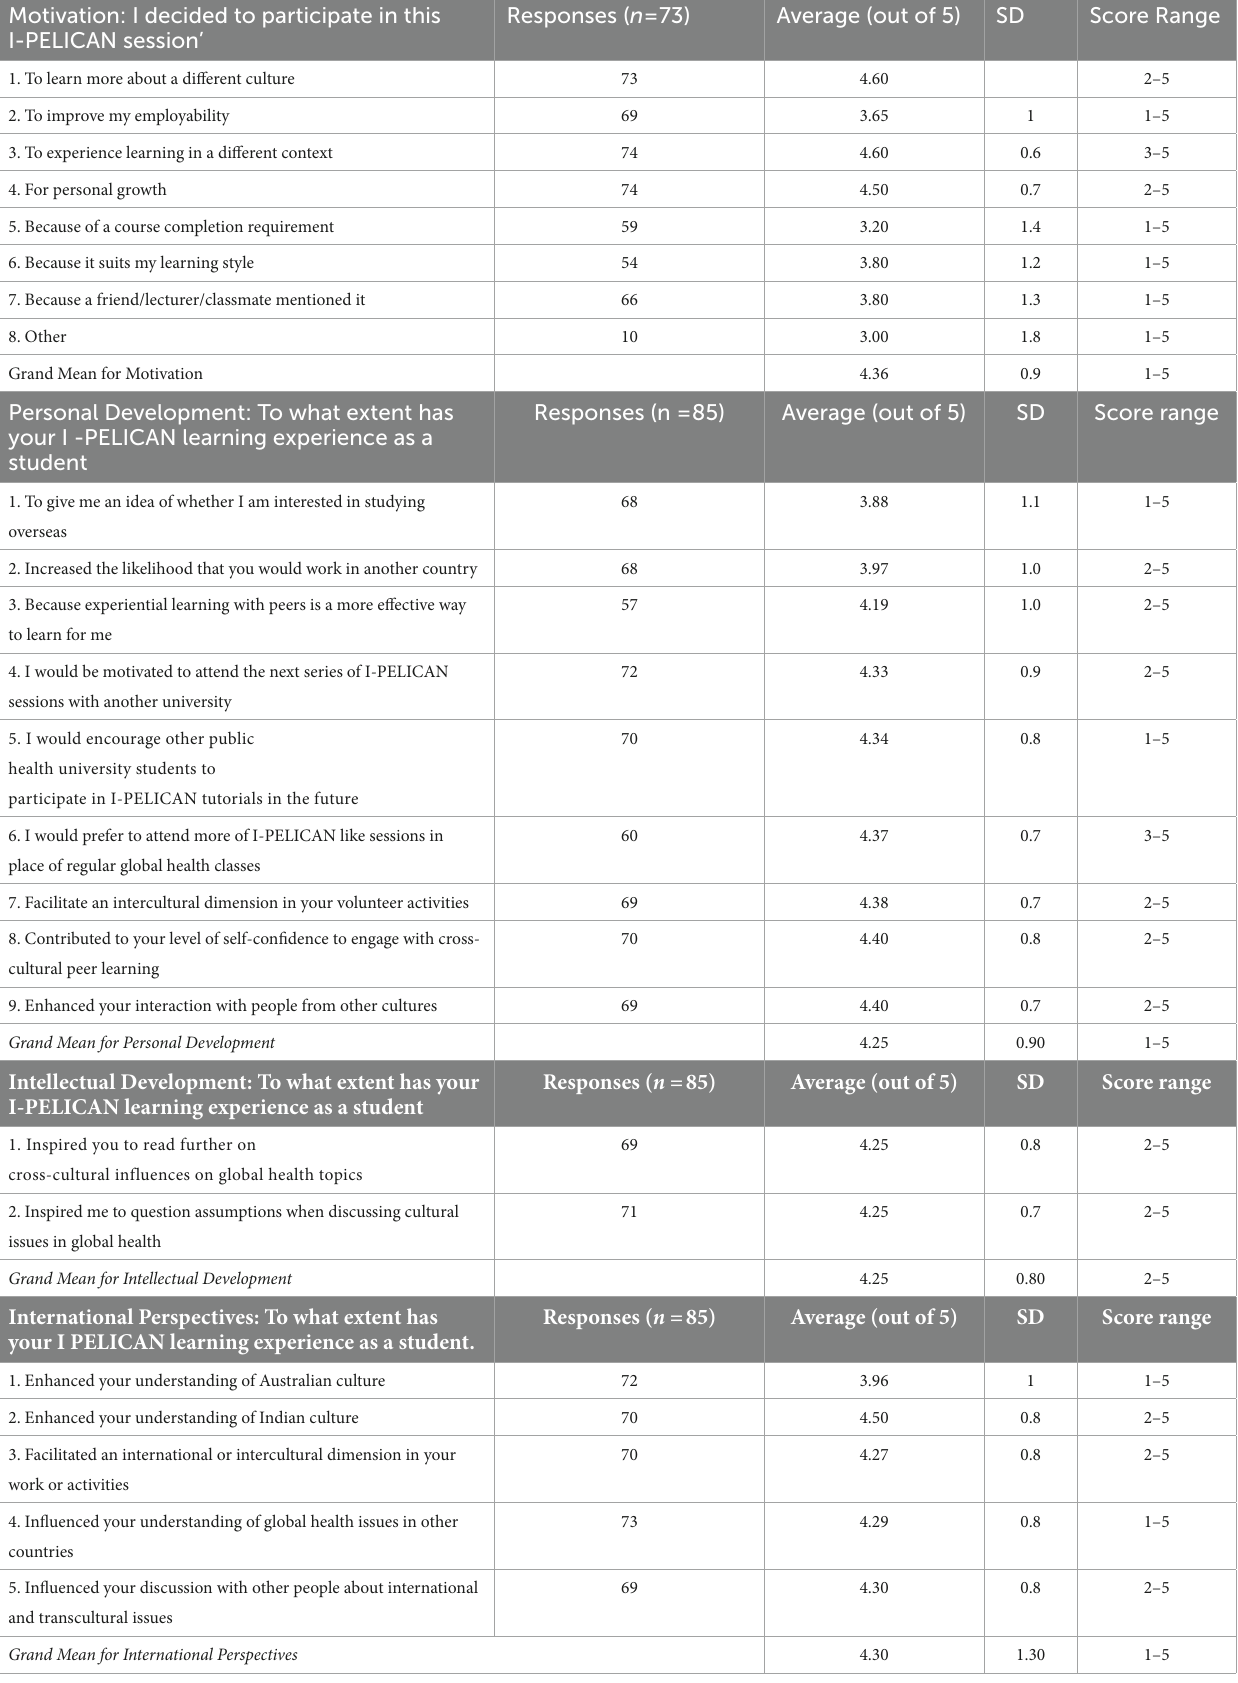
TABLE 2 Aggregated student results for the key domains of “Motivation,” “Personal Development,” “Intellectual Development,” and “International Perspectives” from modified international education survey. Motivation: I decided to participate in this I-PELICAN